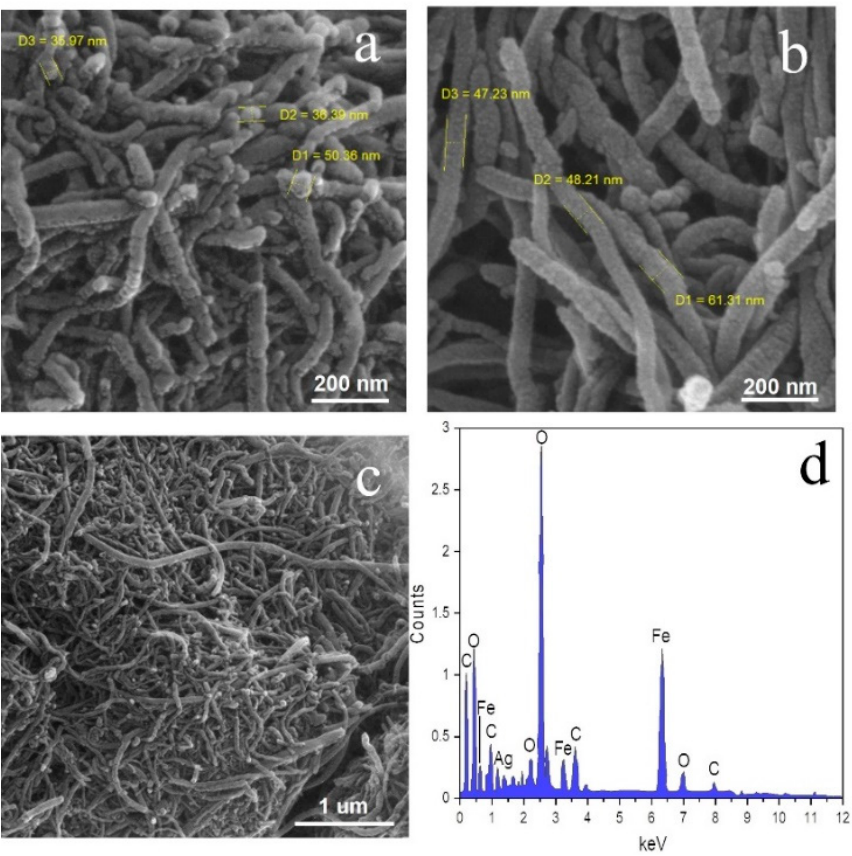
Figure 3. FESEM images of γ -Fe 2 O 3 /MWCNTs ( a , b ), and γ -Fe 2 O 3 /MWCNTs/Ag NC ( c ). ( d ) EDX spectrum of γ -Fe 2 O 3 /MWCNTs/Ag NC.